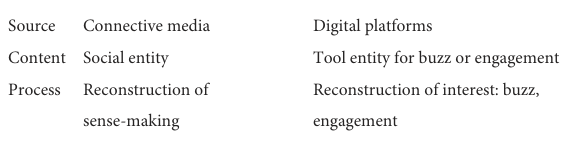
TABLE 2 The dimensions of hashtag